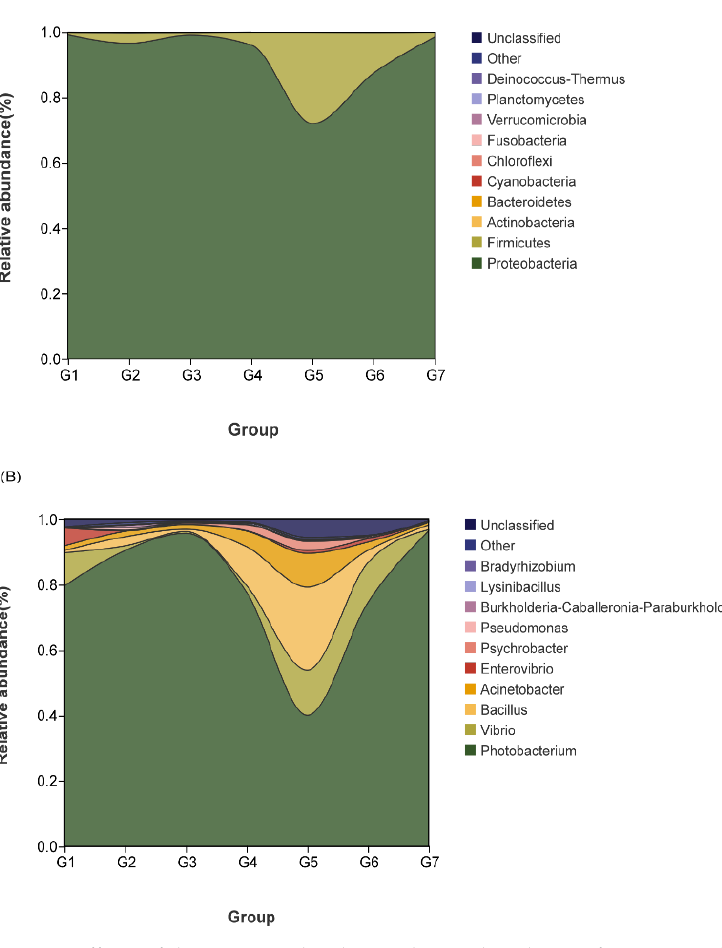
Figure 5. Effects of dietary GML levels on relative abundance of species at phylum ( A ) and genus ( B ) levels for juvenile grouper.